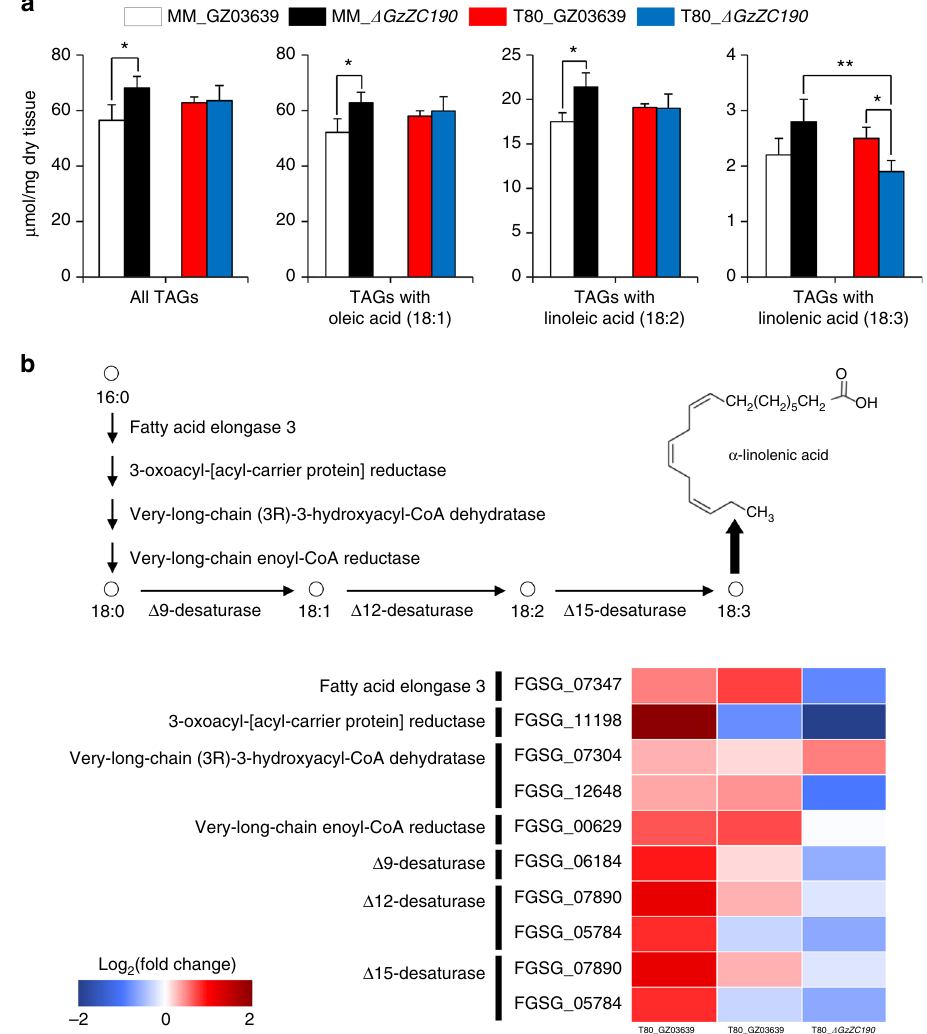
Fig. 3 Quanti fi cation of mycelia TAGs by LC – MS/MS and expression patterns of genes involved in the biosynthesis of linolenic acid (18:3). a Dry mycelia of GZ03639 and Δ GzZC190 ( n = 3 each) were incubated for 24 h in MM with and without toxo fl avin before TAGs were detected with LC – MS/MS. The data presented are the mean ± s.d. (ANOVA; * P < 0.05, ** P < 0.01). b RNA-seq analyses were performed to obtain expression pro fi les of genes involved in the production of linolenic acid (18:3) from palmitic acid (16:0). The KEGG database (http://www.kegg.jp/) and manual annotation based on orthologs of other species were used to annotate genes involved in the production of